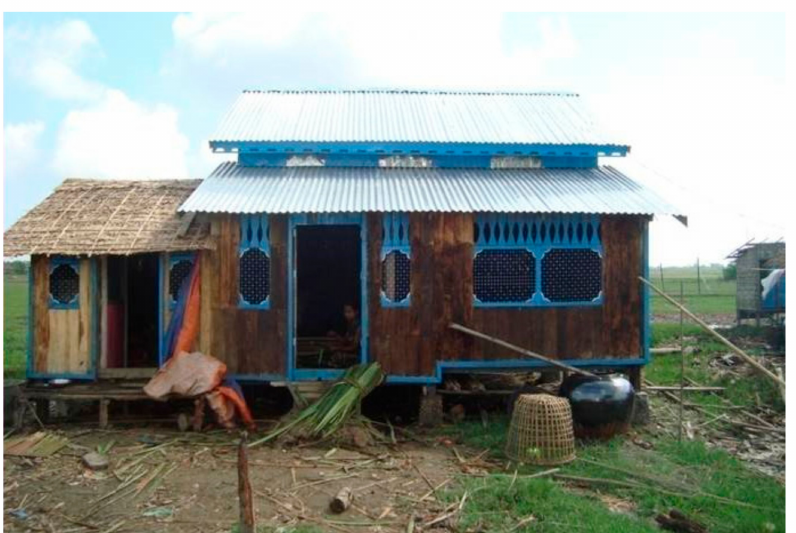
Figure 3. Beneficiaries of the Myanmar Red Cross Society (MRCS) project were able to customize the house design to suit their needs and preferences (source: Daw San San Maw, Myanmar Red Cross Society,